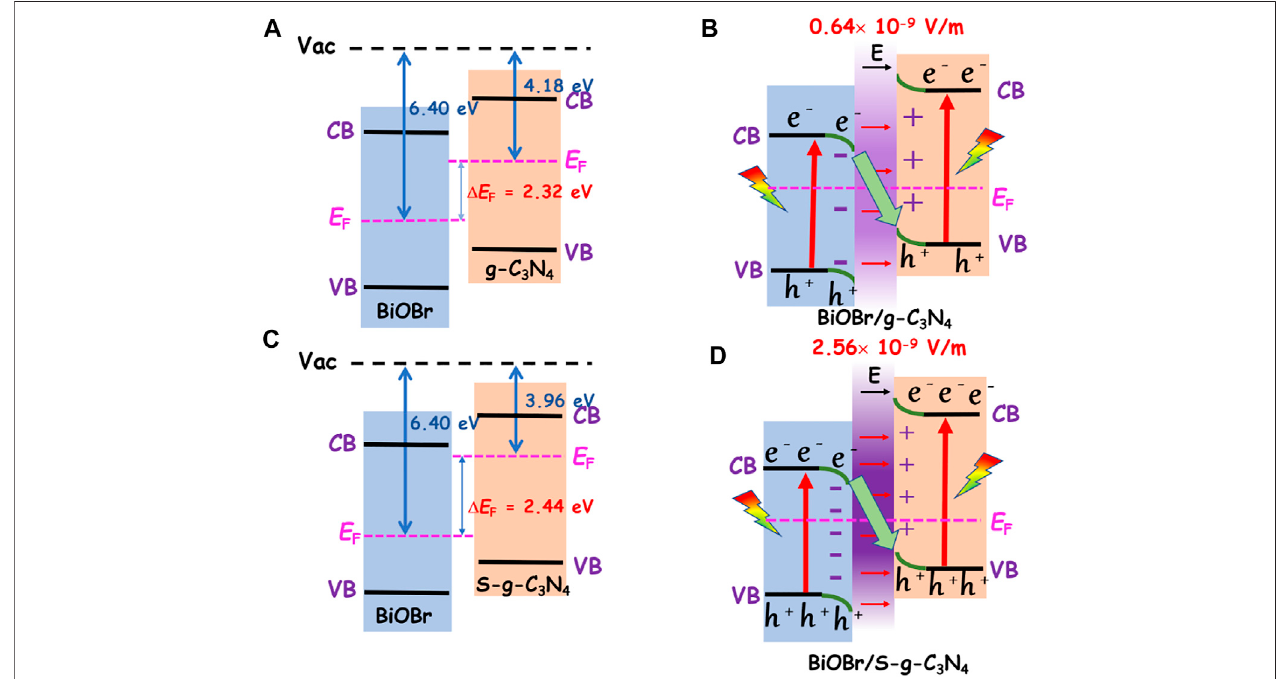
FIGURE6|(A) and (B) arethechargetransfermechanisminBiOBr/g-C 3 N 4 beforeandaftercontact,while (C) and (D) arethechargetransfermechanisminBiOBr/ S-g-C 3 N 4 before and after contact.